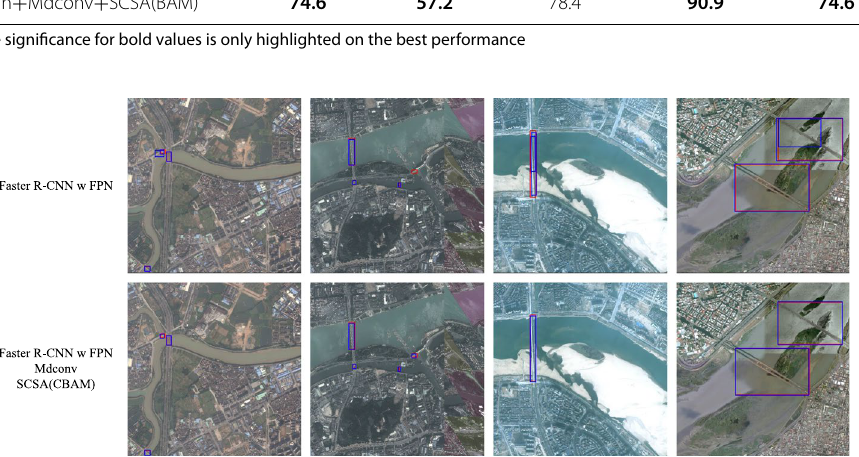
Fig. 8 Examples of test